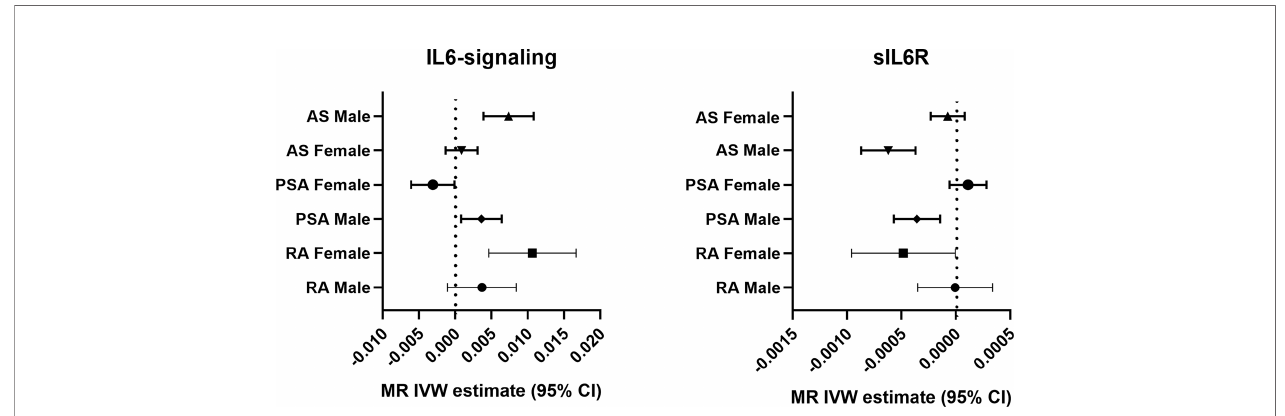
FIGURE 3 | Forest plot of the causal association between IL6-signaling/sIL6R and autoimmune arthritis by